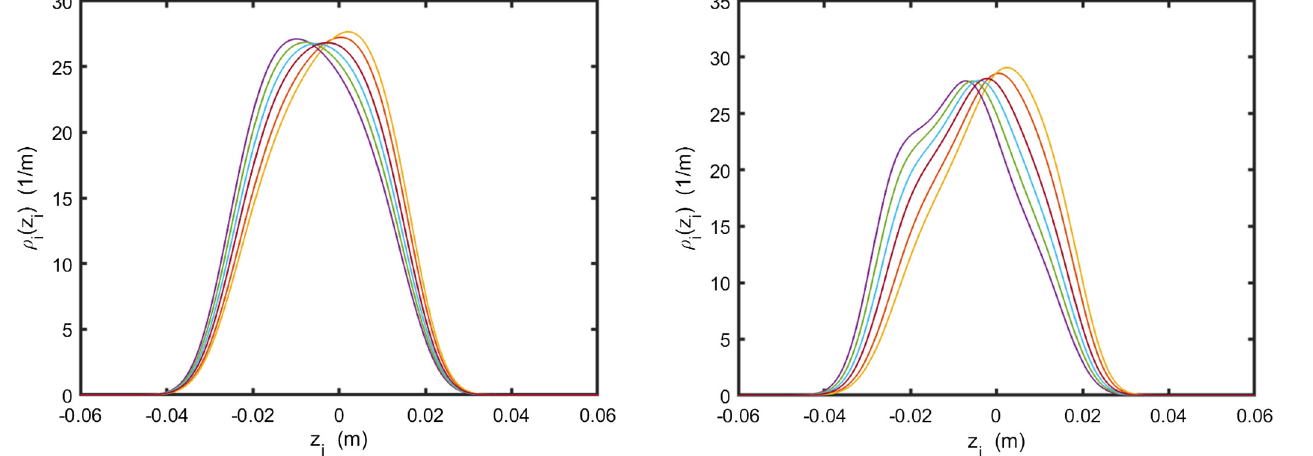
FIG. 19. Fill C2, HHC alone, I